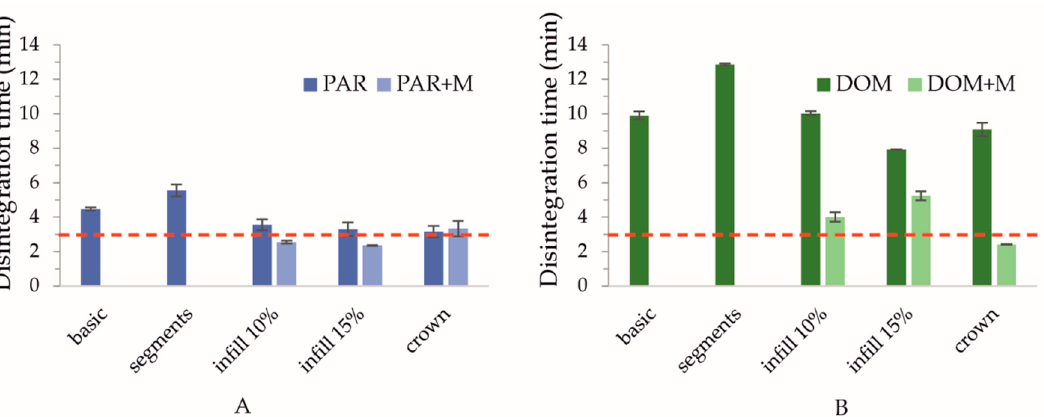
Figure 3. Disintegration time of paracetamol- ( A ) and domperidone-loaded tablets ( B ) stored for 24 h in a desiccator (22.7 °C, 35% RH). The red dashed line represents the maximum disintegration time of the ODTs according to Ph. Eur.